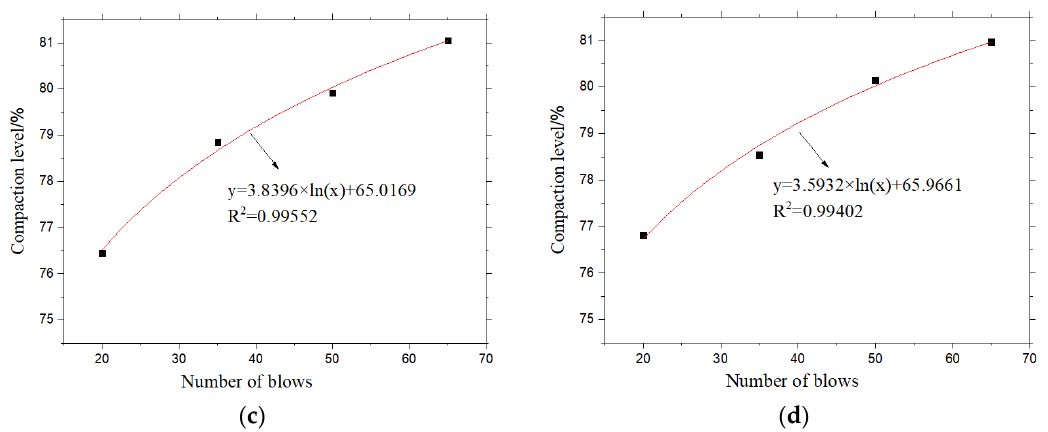
Figure 10. Effects of number of blows on Marshall sample compaction: ( a ) PAC-1-I, ( b ) PAC-1-II, ( c ) PAC-2-I, ( d ) PAC-2-II.